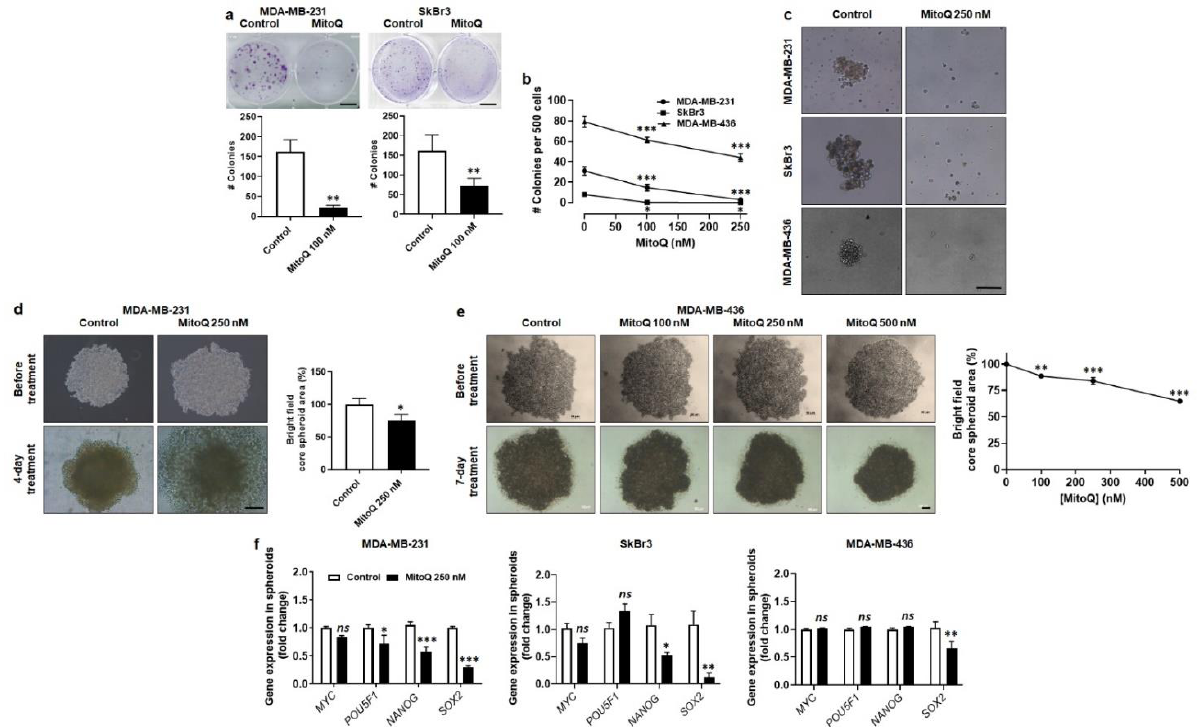
Figure 6. MitoQ represses human breast cancer cell clonogenicity, sphere formation and spheroid stability. ( a , b ) Cells were pretreated for 48 h with the indicated doses of MitoQ. ( a ) Clonogenic assay using adherent MDA-MB-231 (left, n = 6) and SkBr3 (right, n = 9) cells. Bars = 1 cm. ( b ) Clonogenic assay on soft agar using MDA-MB-231 ( n = 16), SkBr3 ( n = 16) and MDA-MB-436 ( n = 8) cells. ( c ) Shown are representative images of MDA-MB-231, SkBr3 and MDA-MB-436 spheroid formation over 4 days in the presence or not of 250 nM MitoQ. Bar = 250 µm. ( d ) Representative images of mature MDA-MB-231 spheroids before and after 4 days of treatment ± 250 nM MitoQ are shown on the left (Bar = 250 µm). On the right, the graph represents spheroid size determined using the bright field mode of phase contrast microscope ( n = 9–11). ( e ) As in d, but using MDA-MB-436 cells and a treatment of 7 days ( n = 6 all; bars = 50 µm for images on the top and 200 µm for images on the bottom). ( f ) mRNA expression of cancer stem cell markers MYC , POU5F1 (Oct4), NANOG and SOX2 in MDA-MB-231 (left, n = 3–7), SkBr3 (middle, n = 4–6) and MDA-MB-436 (right, n = 4–8) spheres treated for 48 h ± 250 nM MitoQ. All data are shown as means ± SEM. * p < 0.05, ** p < 0.01, *** p < 0.001 compared to control; ns : p > 0.05 compared to control; by Student t test ( a , d , f ) or one-way ANOVA followed by Dunnett’s post hoc test ( b , e ).